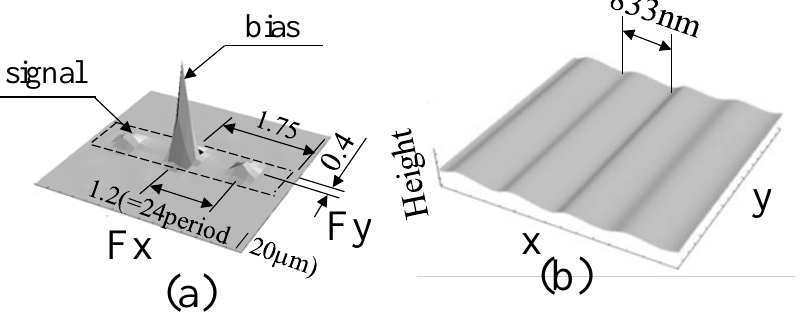
Figure 5. Result in one-dimensional analysis. ( a ) Specklegram in frequency domain; ( b ) Measured result. Phase component φ 1-2 was detected from the signal after noise removal using the spatial fringe analysis method as shown in Figure 3(6). The passband is shown in Figure 5a as the area surrounded by the dashed line (Fx: 1.75 = 35 period/20 µ m, Fy: 0.4 = 8 period/20 µ